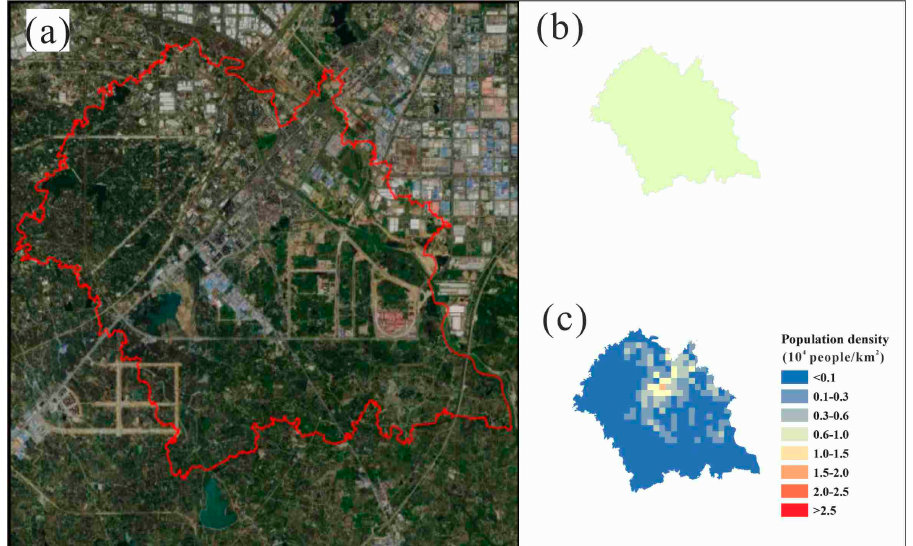
Figure 9. Comparison of ( a ) the high-resolution image, ( b ) the population density at the township scale, and ( c ) that at the 500 m scale in Shangpai Township as the medium-density areas. Figures 8–10 depict the comparison between Google Earth high-resolution images, census data, and population density at a 500 m pixel scale. Notably, all population distri- butions at the township scale were homogenous. From the finer-scale maps of the three figures, the pixels at the administrative boundary of the townships are segmented. The value of independent variables in the segmented pixel is determined by the township with the pixels’ largest area. However, the two segmented parts are involved in the calculation, resulting in the repeated calculation of the boundary part. This is one error source in the pixel-scale population distribution Xiage Township belongs to Chaohu City (a county-level city in Hefei), covering an area of 184 km 2 , with a population density of 306.27 people/km 2 . It is located on the north- ern bank of Chaohu Lake, with beautiful scenery. The township (Figure 10a) mainly con- sists of mountainous terrain with vast tracts of forests, and the residential areas are dis- tributed in the southern part, as shown in Figure 10c.